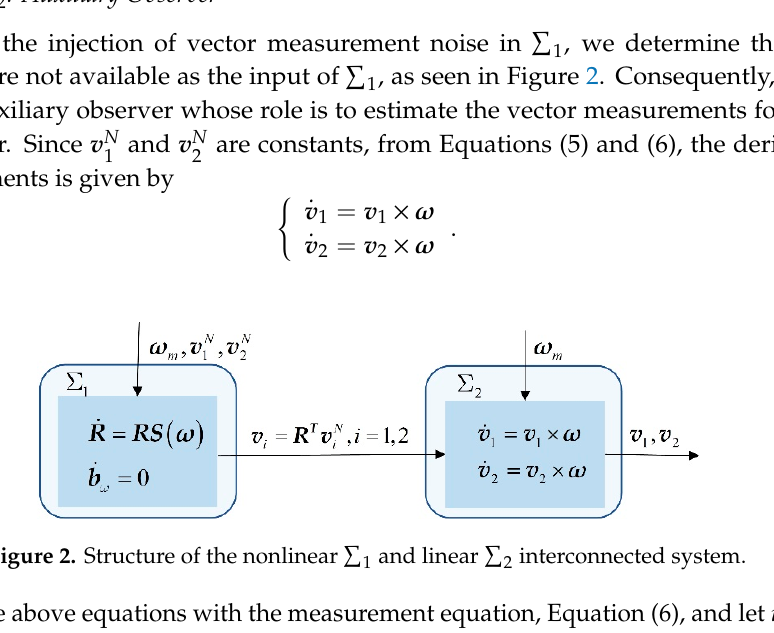
Figure 2. Structure of the nonlinear 